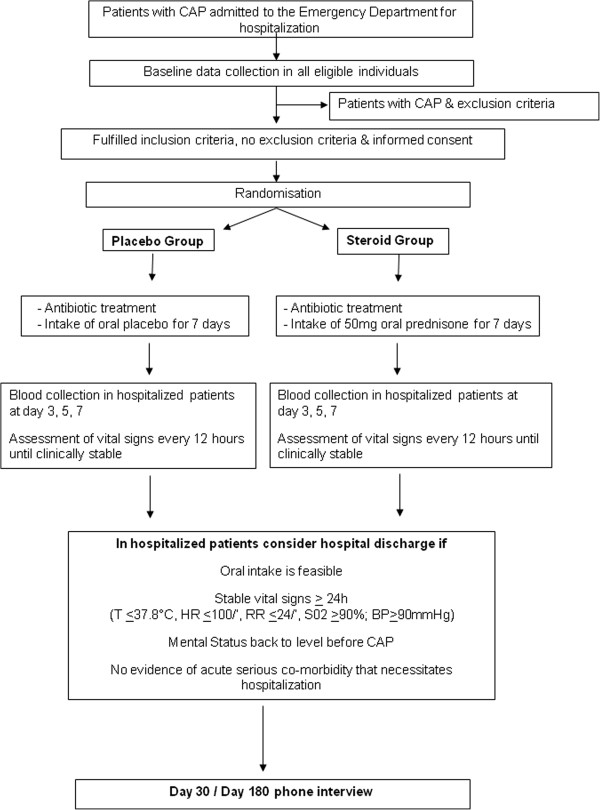
Study flow chart.